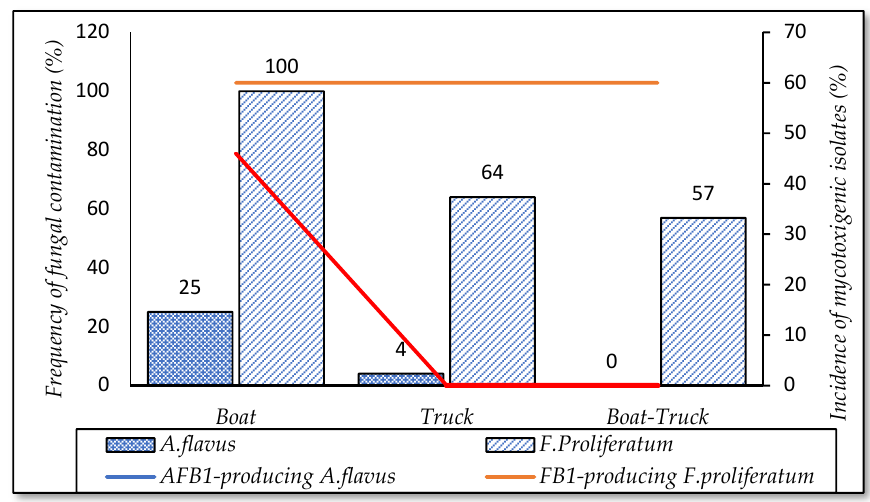
Figure 9. Incidence of fungal contamination and mycotoxigenic fungi in means of transportation.